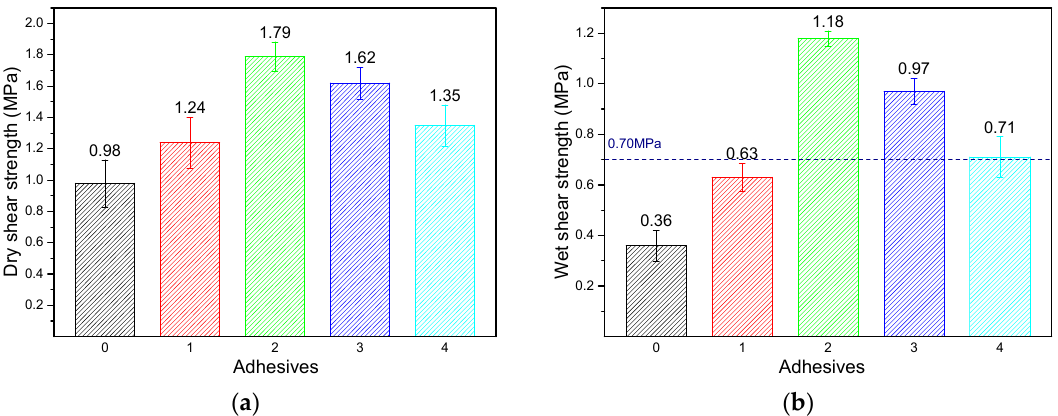
Figure 2. The dry shear strength ( a ) and wet shear strength ( b ) of the plywood bonded with the different adhesives: 0 (SM adhesive), 1 (SM/DRE-2 adhesive), 2 (SM/DRE-4 adhesive), 3 (SM/DRE-6 adhesive), 4 (SM/DRE-8 adhesive).